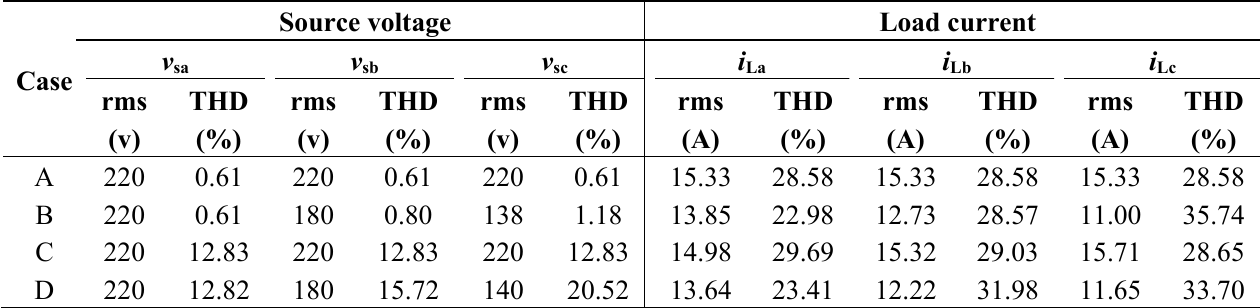
Table 2. Grid voltage, load current and THDs under different grid voltage conditions.